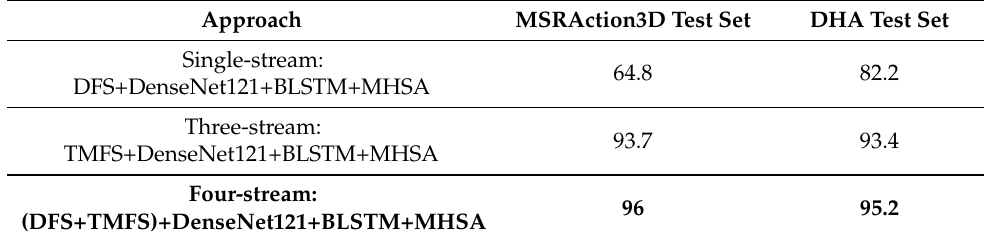
Table 5. Observation of effectiveness of four data streams in model development.